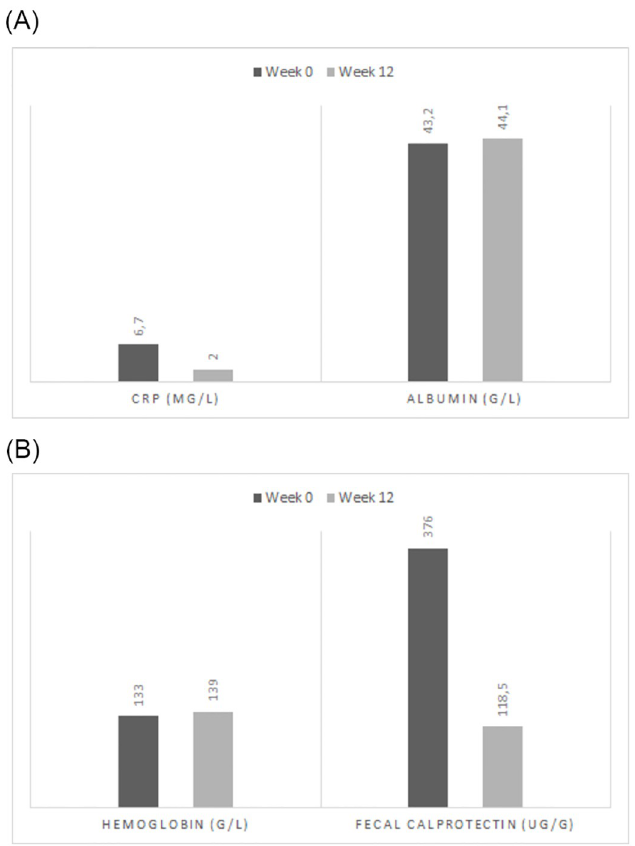
Fig 2. A : The trend of CRP and ALBUMIN before and after 12 weeks of therapy. B : The trend of HEMOGLOBIN and FECAL CALPROTECTIN before and after 12 weeks of therapy.